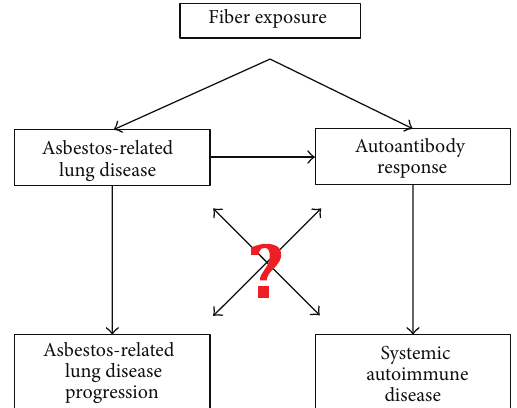
Figure 2: Proposed relationships between asbestos exposure, autoimmunity, and fibrotic lung disease progression. Data (as men- tioned in the text) support the connections indicated, but questions remain regarding (a) the types of fibers that are responsible and (b) the etiological and mechanistic bases for the